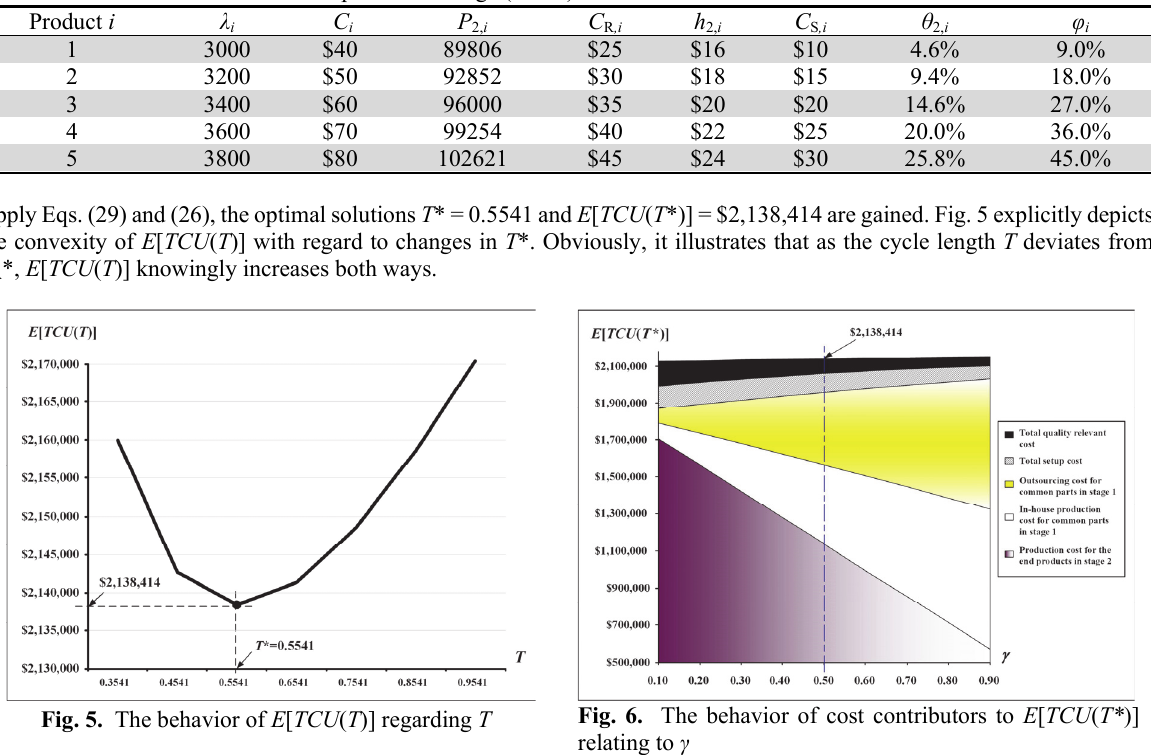
Parameters’ values used in the second production stage (2 of 2)